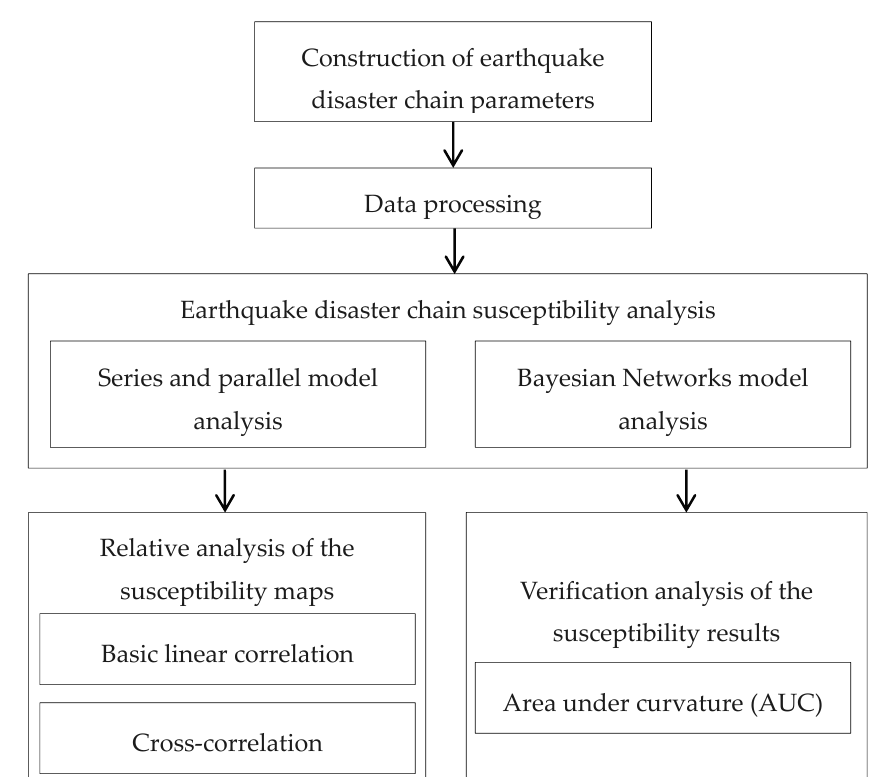
Figure 1. Flowchart showing the methodology employed in this study.